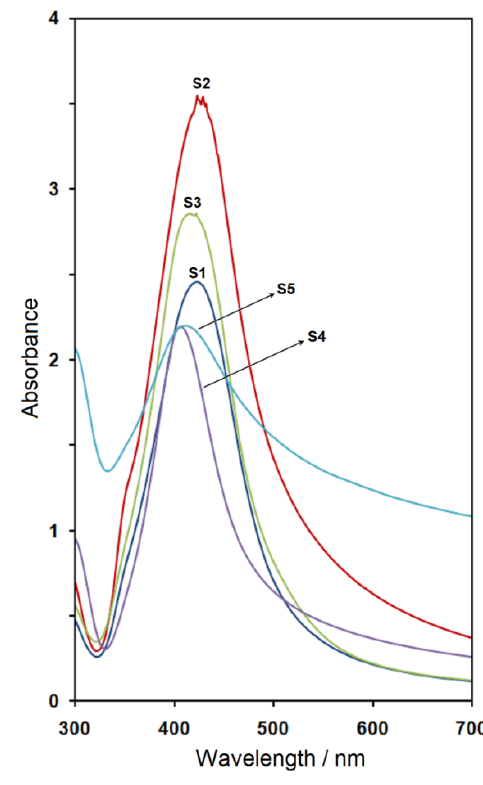
Figure 2. The UV-visible spectra of Ag-NPs prepared at different volumes of